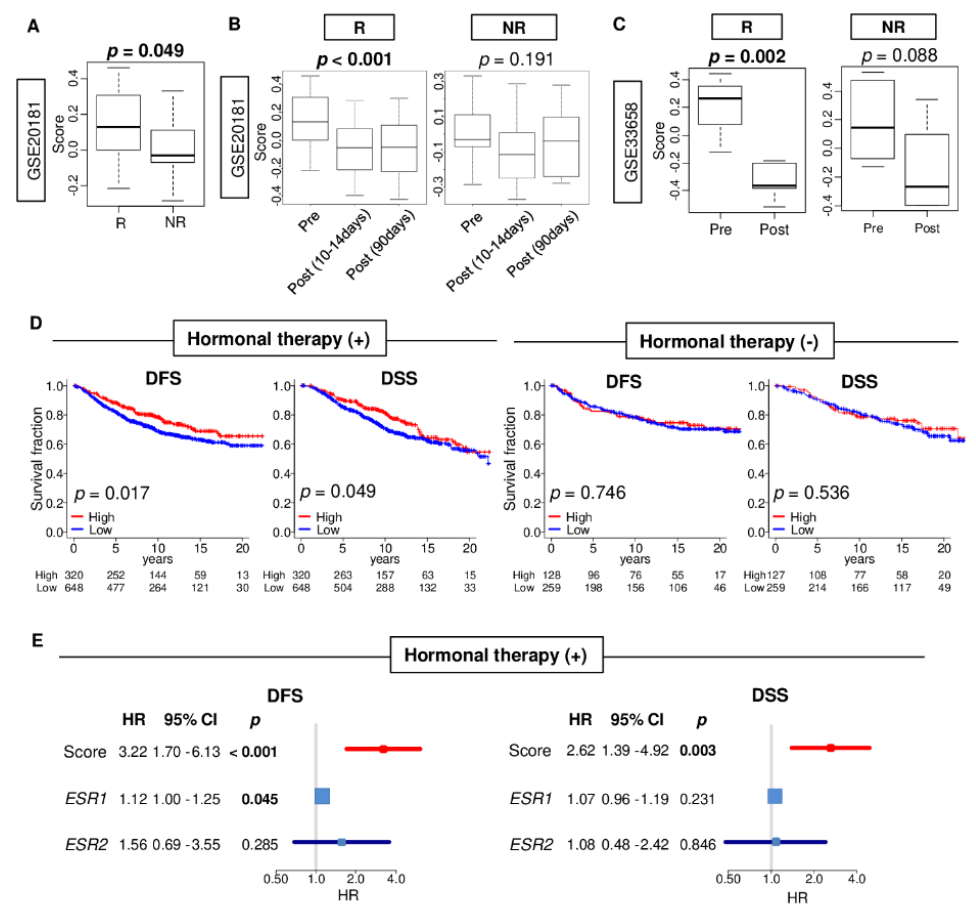
Figure 5. Association of the estrogen response early score with treatment response to endocrine therapy in estrogen receptor (ER)-positive breast cancer. ( A ) A boxplot of the comparison of the score between response (R) and non-response (NR) group in the GSE20181 cohort ( n = 176) that received letrozole. ( B ) Boxplots comparing the score between pre-treatment, post- (10–14 days) and post- (90 days) treatment tumors in the GSE20181 cohort. ( C ) Boxplots of the comparison of the score between pre- and post-treatment tumors in the response group and non-response group in the GSE33658 cohort that underwent anastrozole and fulvestrant ( n = 22). p -value was calculated by one-way ANOVA test. ( D ) Kaplan-Meier with log-rank p -value between low (blue) and high (red) score with disease-free survival (DFS) and disease-specific survival (DSS) in the treatment group and non-treatment group in the METABRIC cohort. The top one-third was defined as the high score group within the cohort. ( E ) Forrest plots of the estrogen response early score, ESR1 and ESR2 expression with DFS and DSS in an endocrine therapy group in the METABRIC cohort. The p -value was calculated by Cox regulation model. HR; hazard ratio, CI; confidence interval.